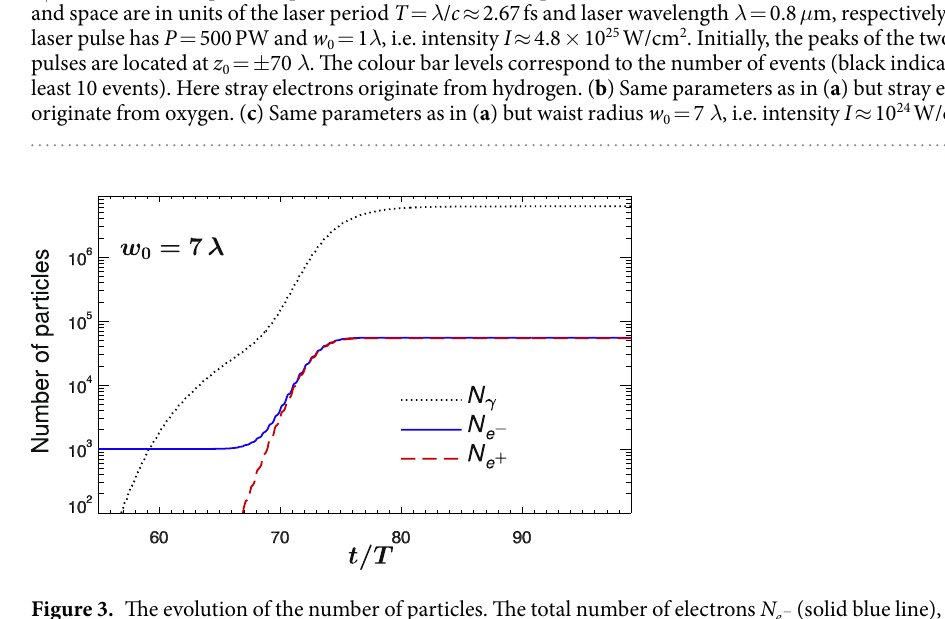
Figure 3. The evolution of the number of particles. The total number of electrons − N positrons + N (dashed red line) and photons N γ with energy ε γ > 2.5 MeV (dotted black line) as function of time e t during the collision of two counter-propagating laser pulses. Time and space are in units of the laser period T = λ / c ≈ 2.67 fs and laser wavelength λ = 0.8 μ m, respectively. The two pulses have P = 500 PW power and w 0 = 7 λ waist radius, which imply an intensity I ≈ 10 24 W/cm 2 . The initial 10 3 stray electrons originate from